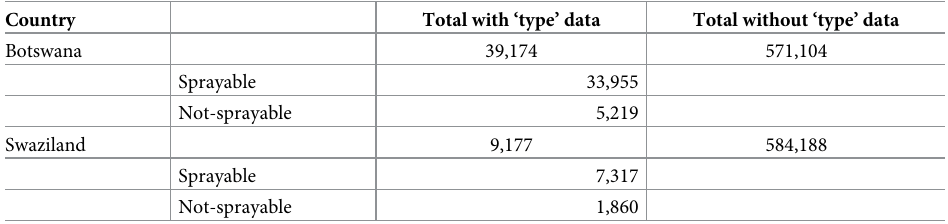
Table 2. Breakdown of details of the OSM structure data available for Swaziland and Botswana.